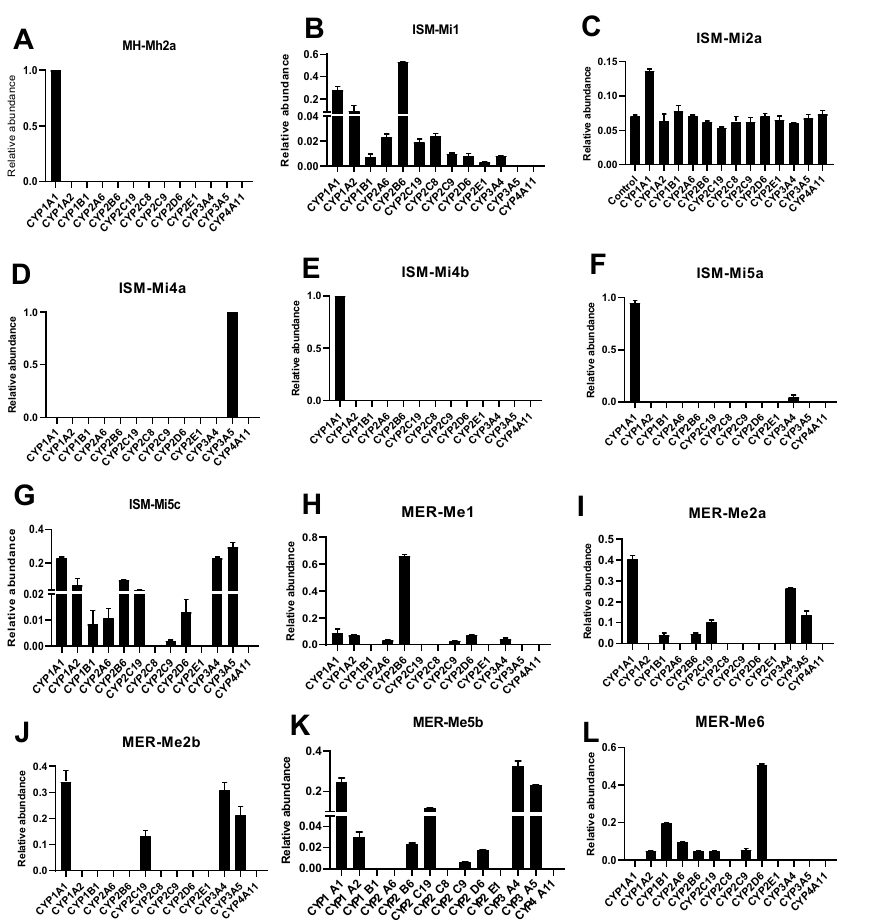
Figure 7. Contribution of CYPs to the formation of in vitro metabolites of MH, ISM, and MER. Relative abundance of CYPs contribute to formation of Mh2a ( A ), Mi1 ( B ), Mi2a ( C ), Mi4a ( D ), Mi4b ( E ), Mi5a ( F ), Mi5c ( G ), Me1 ( H ), Me2a ( I ), Me2b ( J ). Me5c ( K ), and Me6 ( L ).